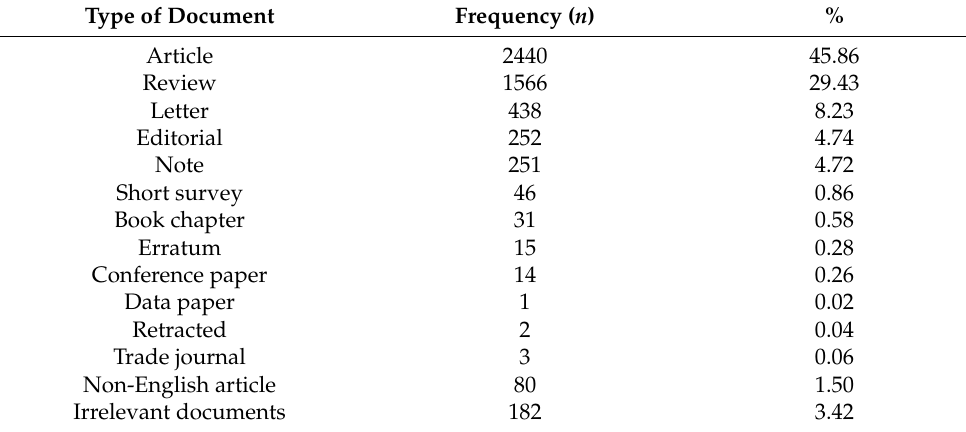
Table 1. Types of retrieved documents on remdesivir research publications